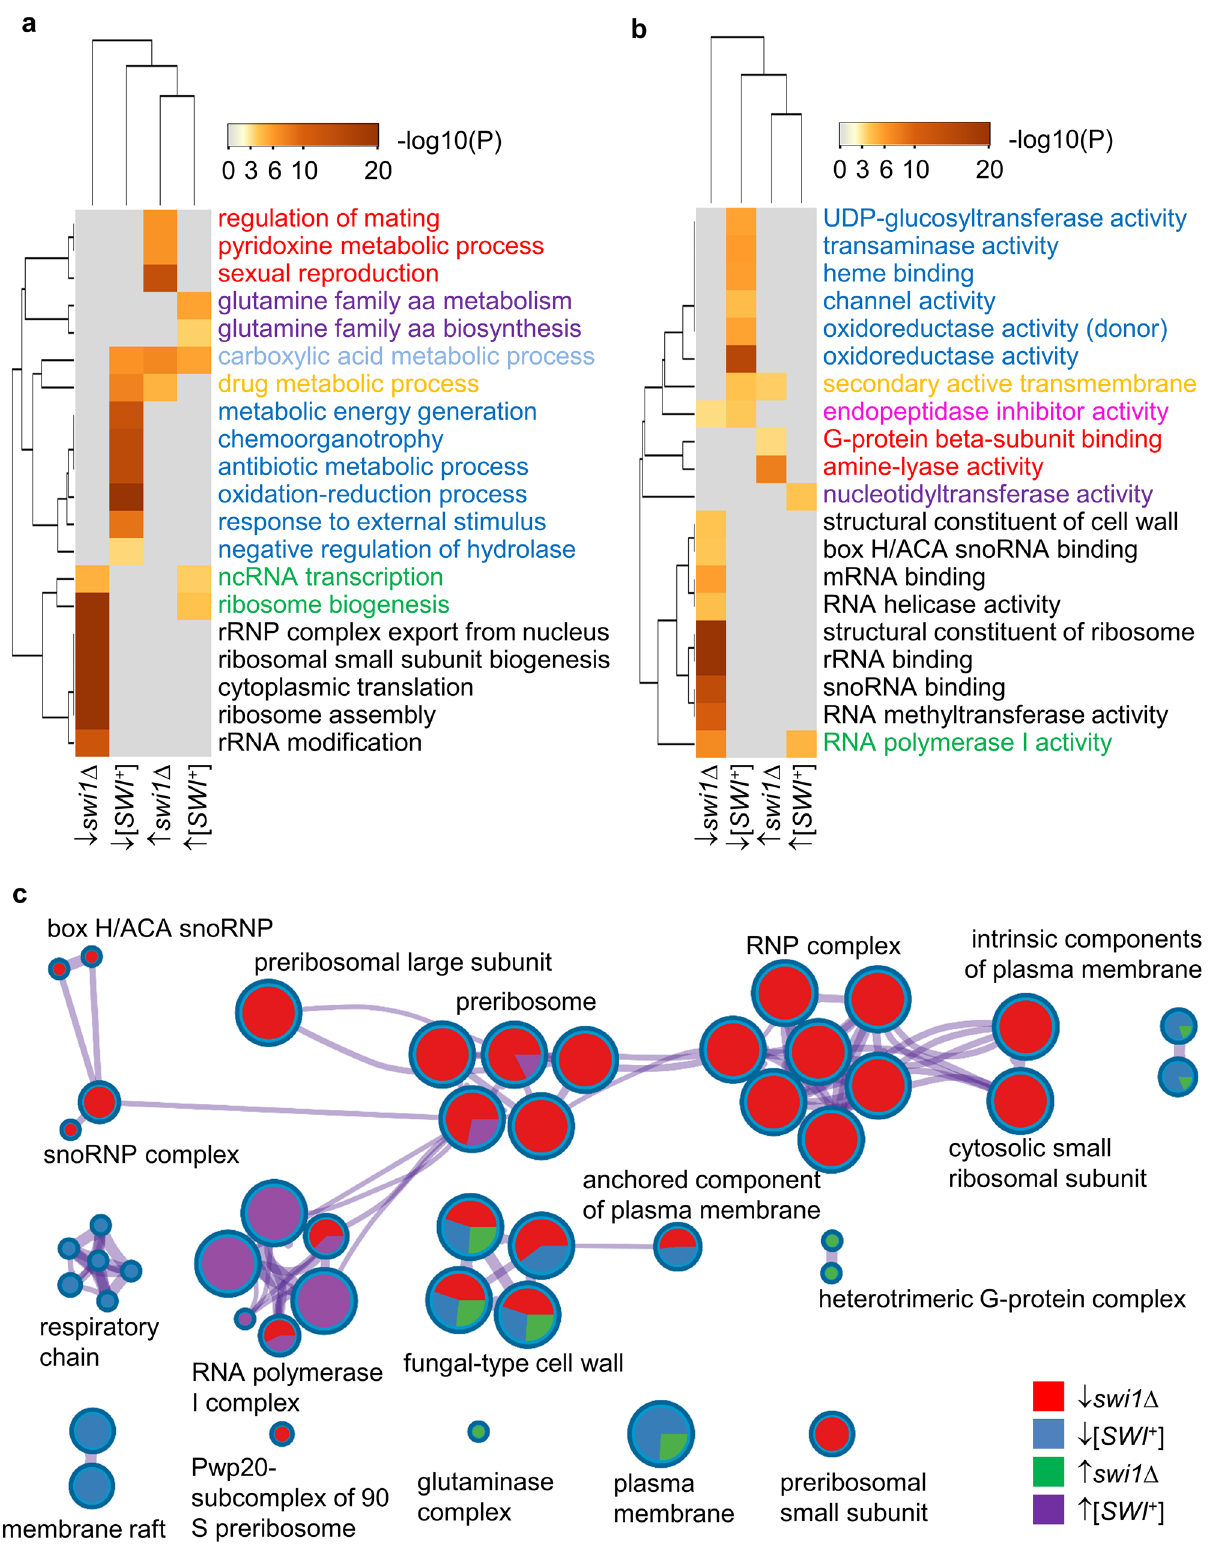
Figure 5. GO term enrichment analyses of [ SWI + ] DEGs and swi1∆ DEGs. The enrichment of biological process ( a ) and molecular function ( b ) and cellular component ( c ) were analyzed for the four indicated subgroups of DEGs using Metascape (http://metas cape. org). The cutoff for a significant enrichment is 0.001 as described in the Methods. In panels ( a , b ) the heatmaps are colored by their p-values as denoted, and the description of each term is highlighted by a specific color based on the enrichment pattern. For panel ( c ), enriched terms from the full cluster are converted into a network layout displayed by a circle node, where its size is proportional to the number of input genes fall into that term, and the color in each pie sector represent its regulatory patterns as shown. The thickness of an edge represents the similarity score. The network was visualized and edited with Cytoscape